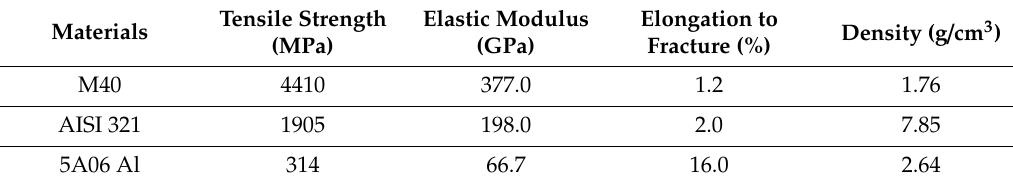
Table 1. Basic properties of carbon fibers, z-pin and 5A06 Al alloy.